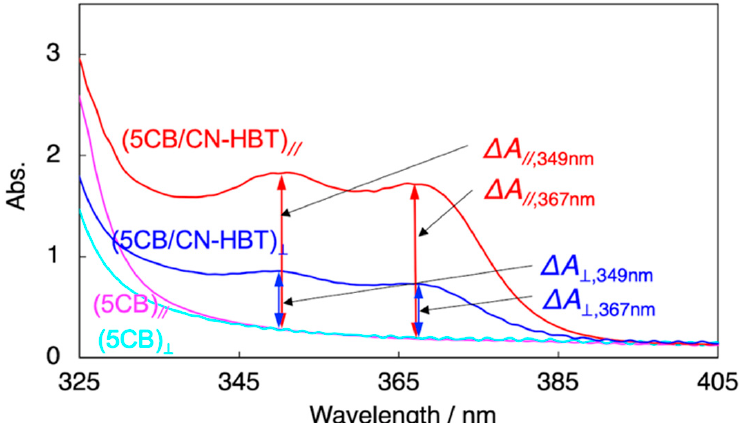
Figure 5. Polarized absorption spectra of 5CB (turquoise, magenta) and 5CB /CN-HBT (99/1 wt/wt) (red, blue) in 15- µ m thick LC cell. The surface of two ITO-glass substrates consisting of the LC cell is coated with rubbed polyimides with a parallel direction. The incident light was polarized at 0° (magenta, red) and 90° (turquoise, blue) from the orientational axis of the cell.